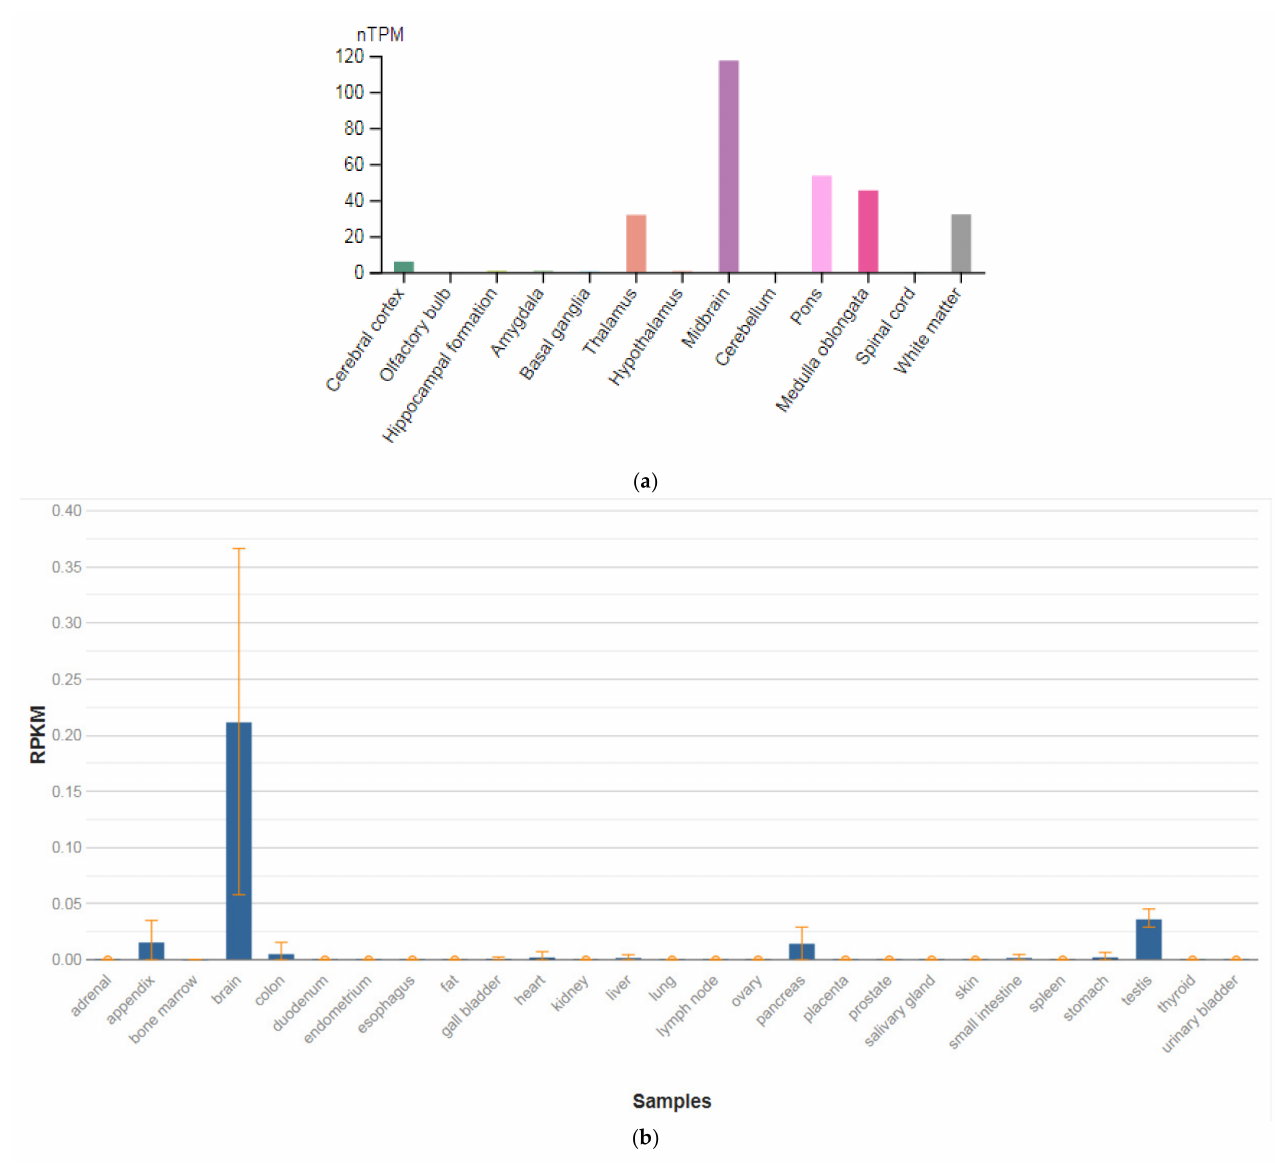
Figure 6. The tissue expression of the tryptophan hydroxylase type 2 in the brain ( a ) and other organs in the human body ( b